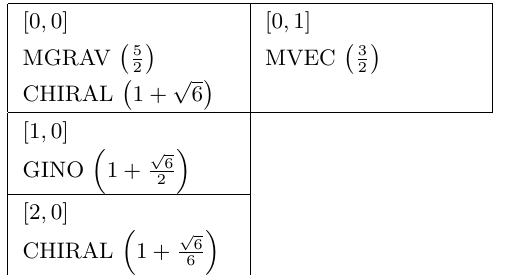
Table 2 . Supermultiplets at KK level n = 0 for the D = 11 N = 1 G 2 -invariant AdS 4 solution.